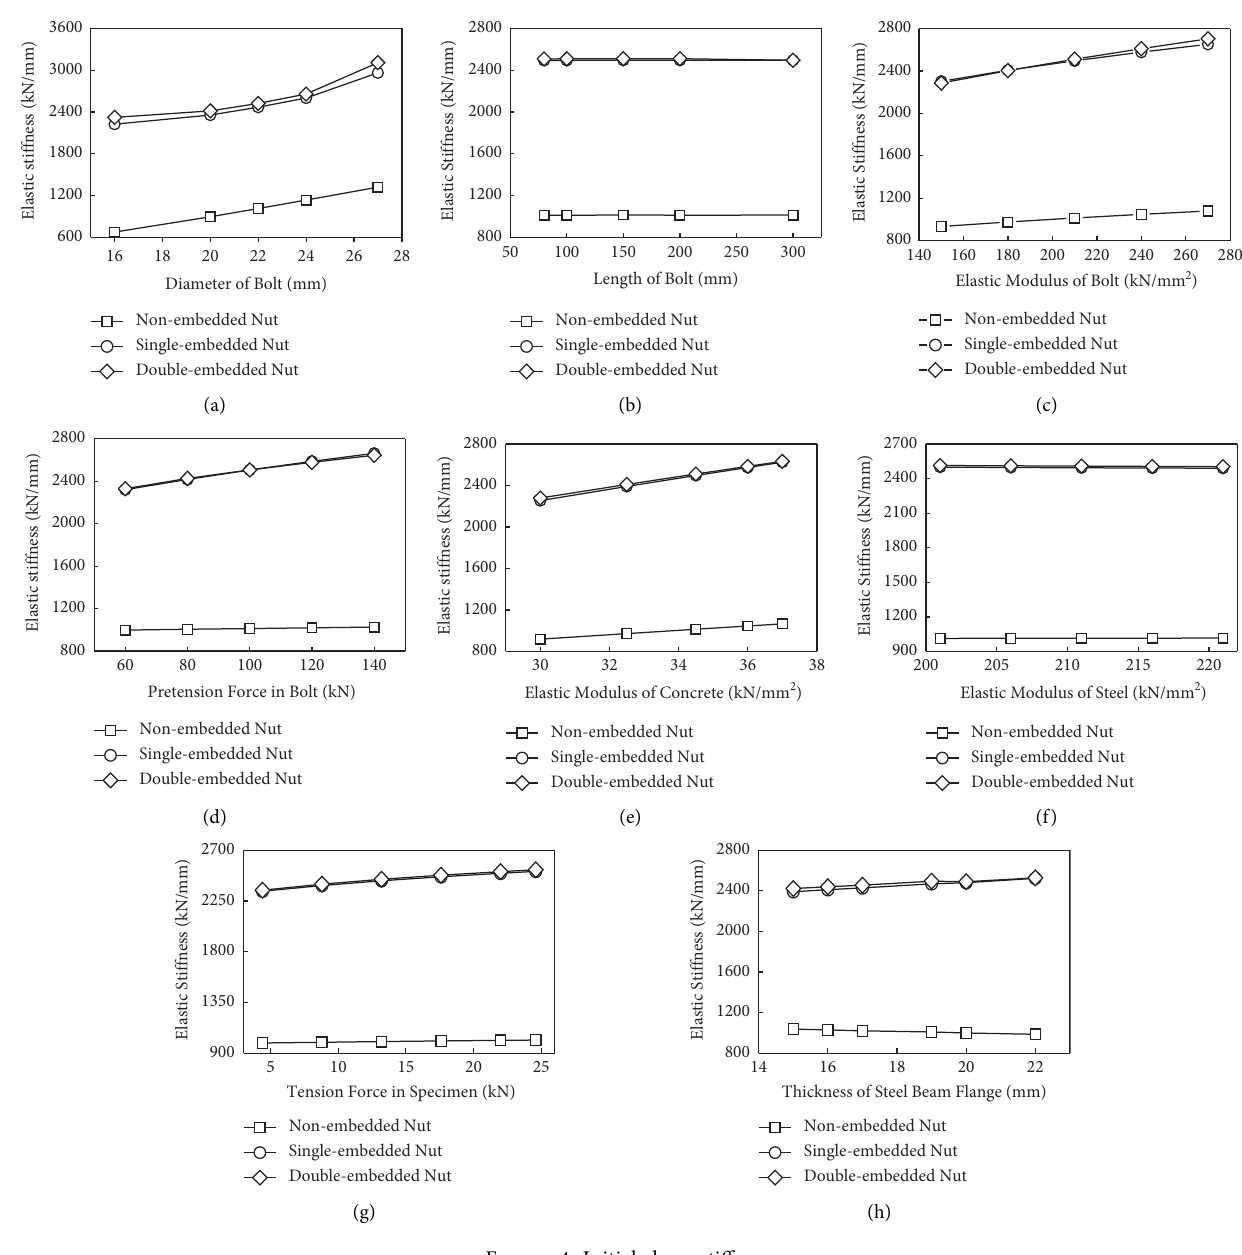
Figure 4: Initial shear